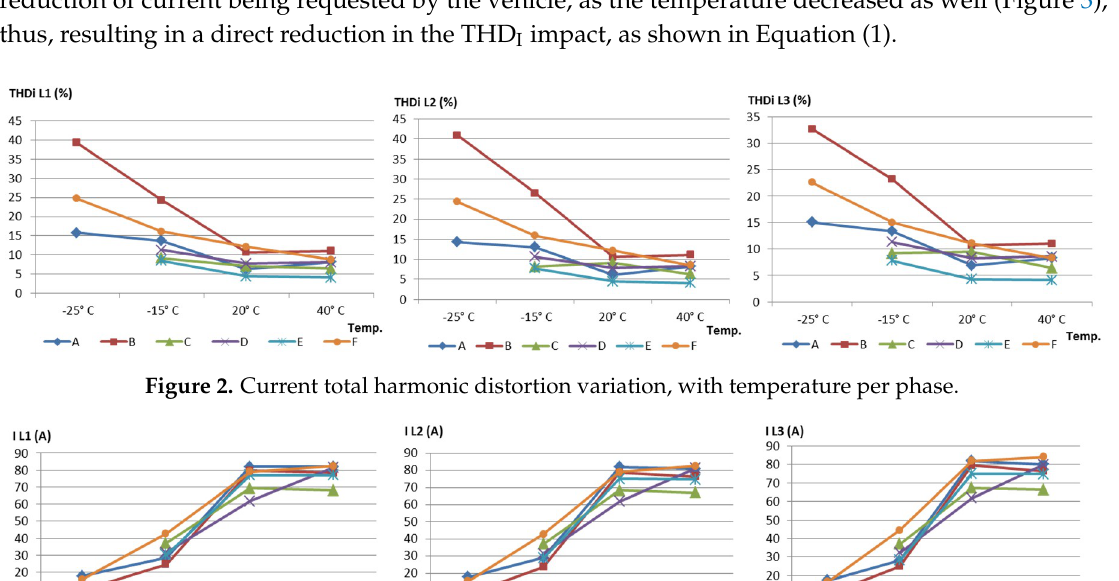
Figure 3. AC charging current (RMS) variation, with temperature per phase.